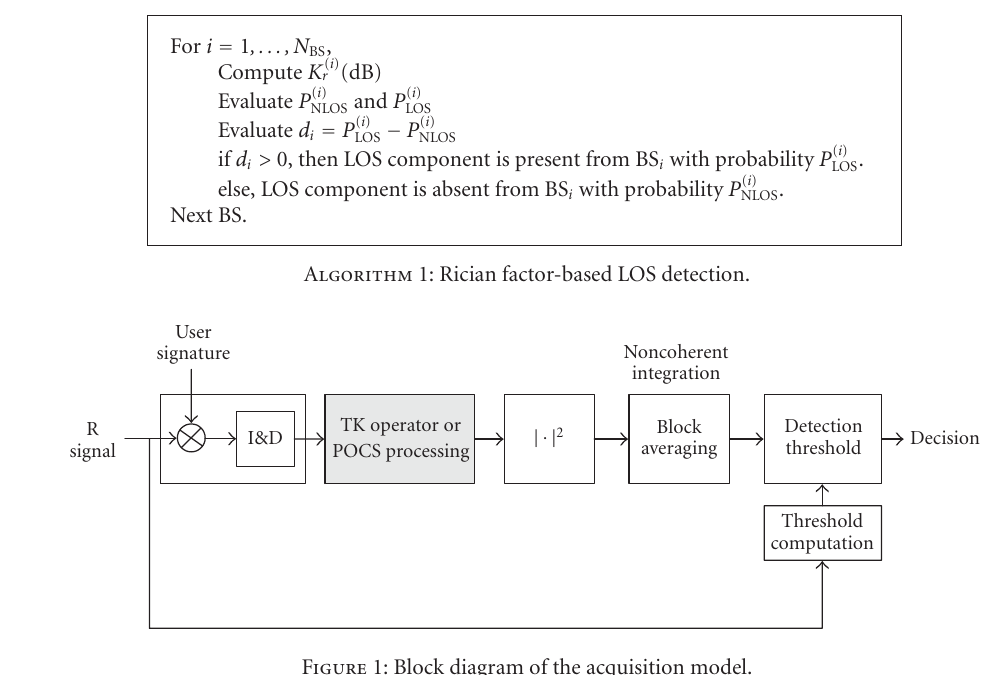
Figure 1: Block diagram of the acquisition